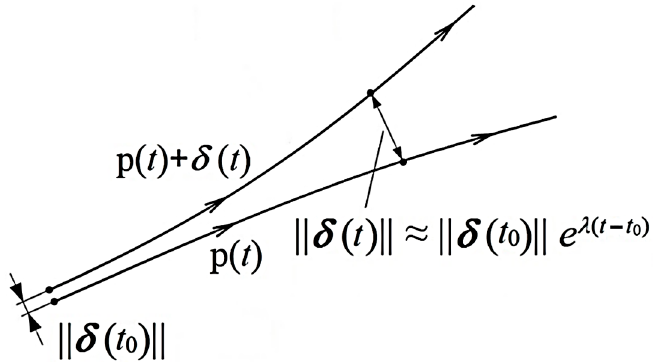
Figure 3. The example of diverging distances based on Lyapunov exponent theory.